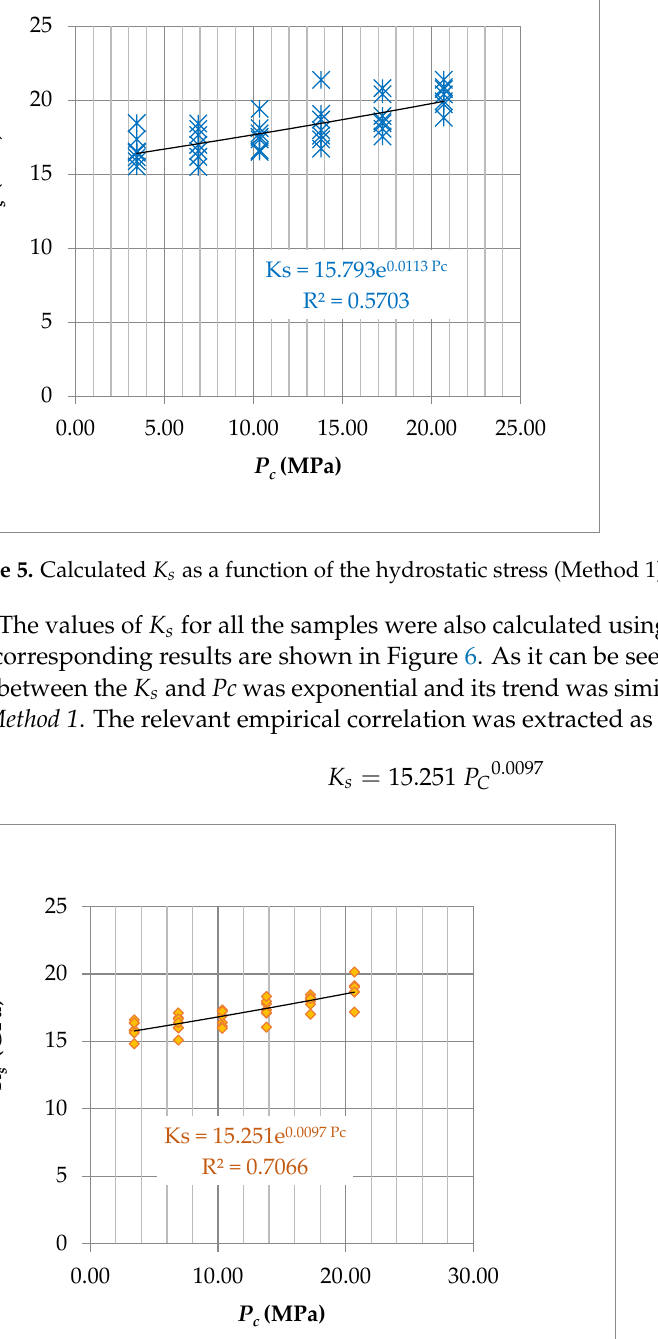
Ks = 15.251e 0.0097 Pc R² = 0.7066